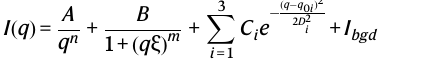
corresponding to the best fi tting using the models mentioned in the text. The q range of three regimes: Regime I (blue shade, 0.003 – 0.02Å − 1 ), Regime II (orange shade, 0.02 – 0.06Å − 1 ), Regime III (gray shade, 0.06 – 0.25Å − 1 ). Color scheme (C: gray; N: blue; O: red; Cu: green; Al: